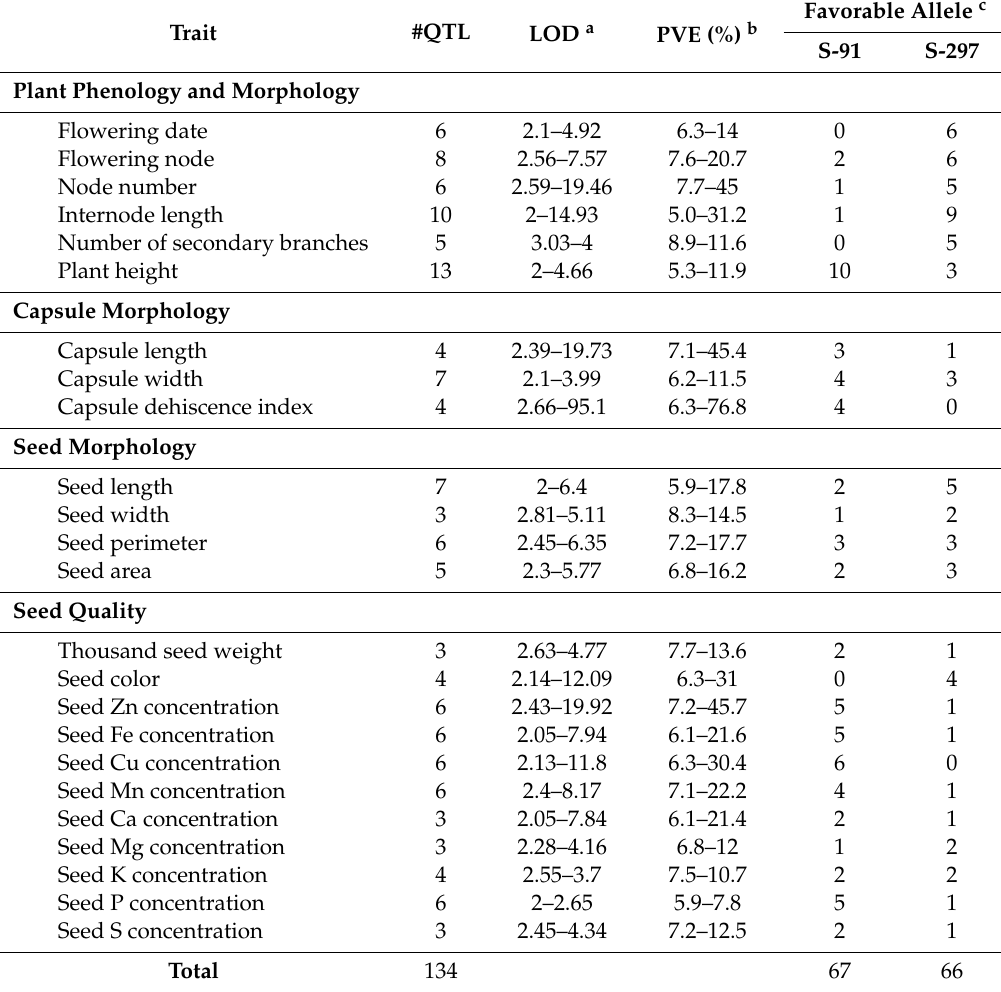
Table 2. Summary of QTL detected in F 2 population (S-91 × S-297) associated with plant phenology and morphology, capsule morphology, seed morphology and seed quality